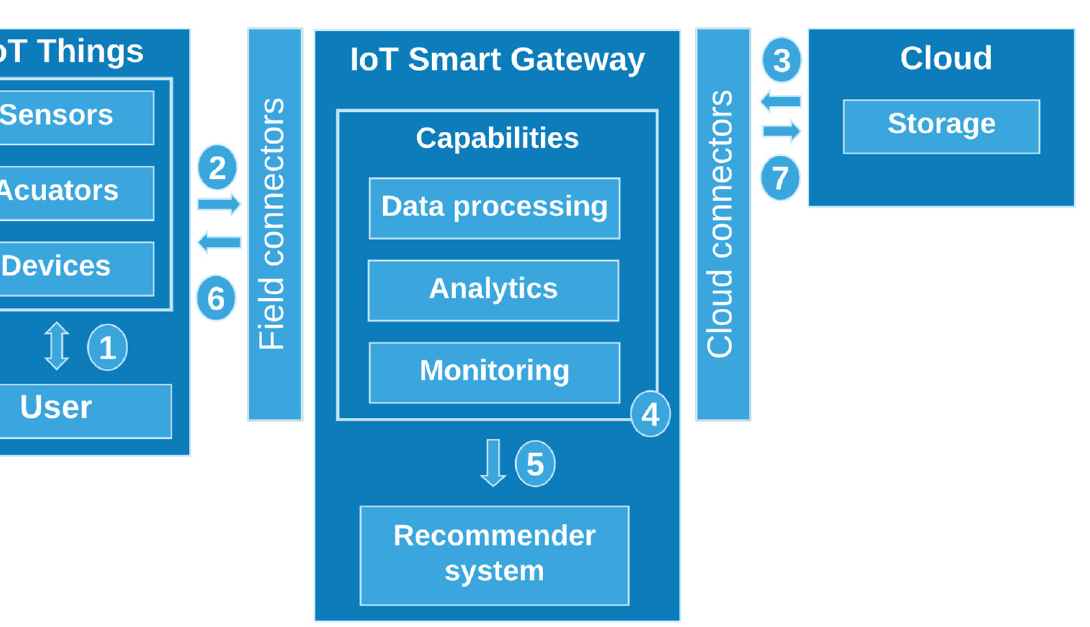
Figure 1. Proposed IoT architecture, with seven steps to follow.